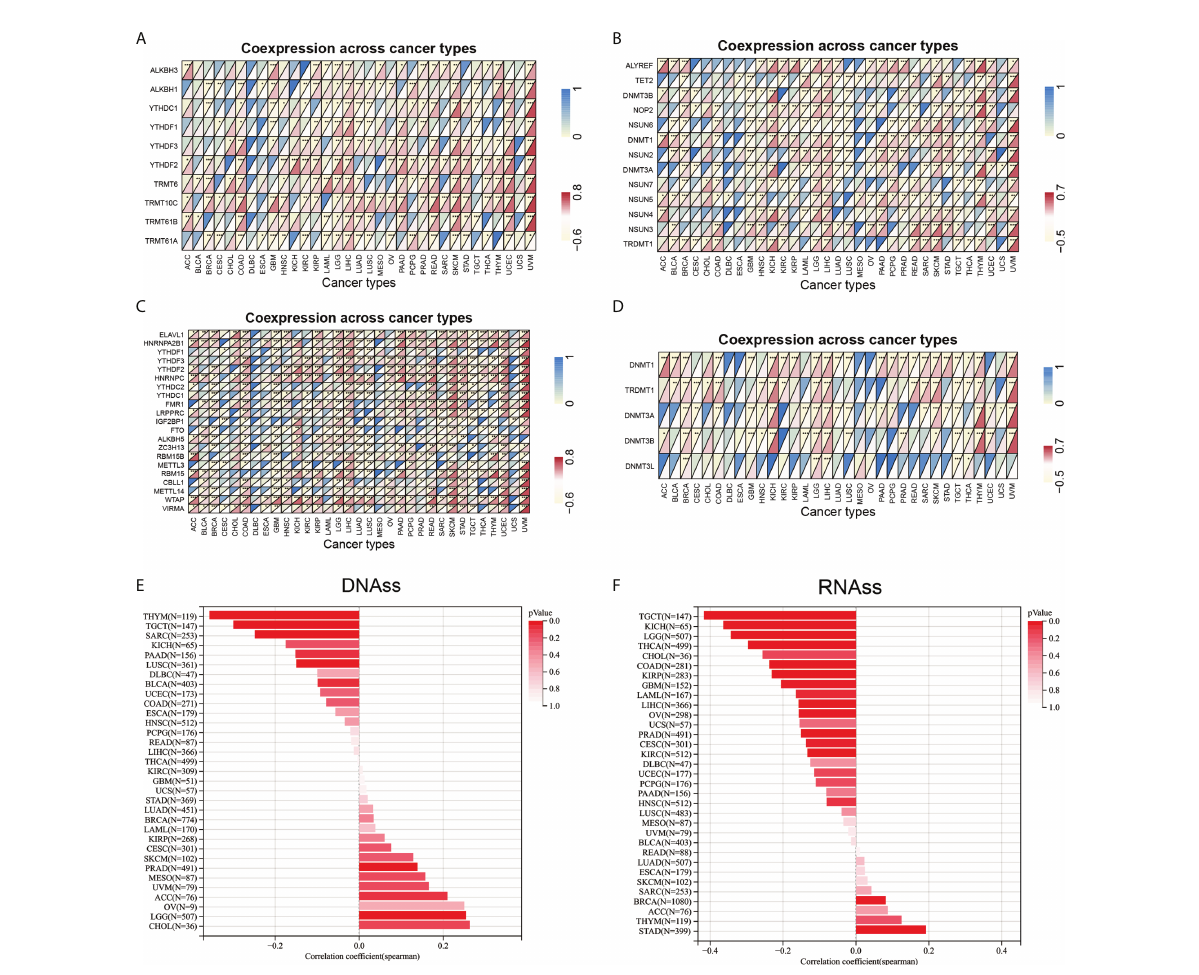
FIGURE 9 Correlation analysis between ARPC5 expression and RNA modi fi cation-related genes, DNA methyltransferases, and tumor stemness score in 33 cancer types. (A) Co-expression of ARPC5 with m1A-related genes. (B) Co-expression of ARPC5 with m5C-related genes. (C) Co-expression of ARPC5 with m6A-related genes. (D) Co-expression of ARPC5 with DNA methyltransferases. (E) The correlation between ARPC5 expression and Tumor Stemness score (DNAss). (F) The correlation between ARPC5 expression and Tumor Stemness score (RNAss). * p < 0.05; ** p < 0.01; *** p <